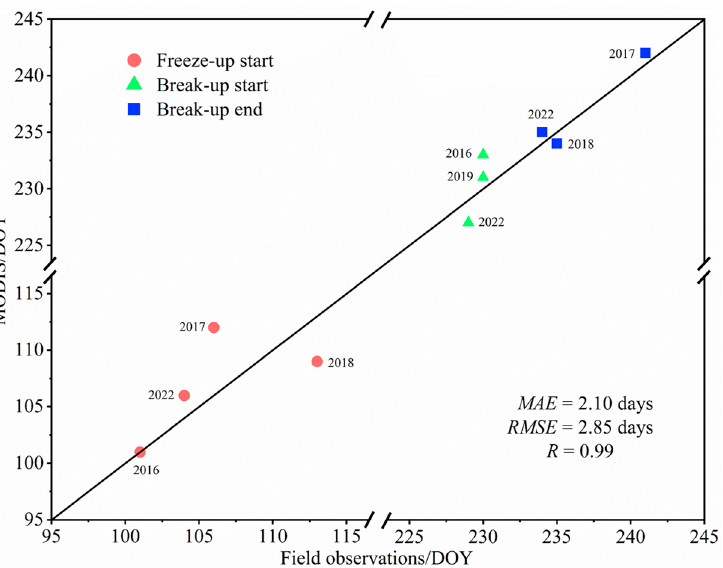
Figure 8. Comparisons of ice phenology dates for Wuliangsu Lake derived from filed observation and MODIS products (DOY means the day of the year relative to 1 August, R is the correlation coefficient, MAE is the mean absolute error, and RMSE is the root mean square error).